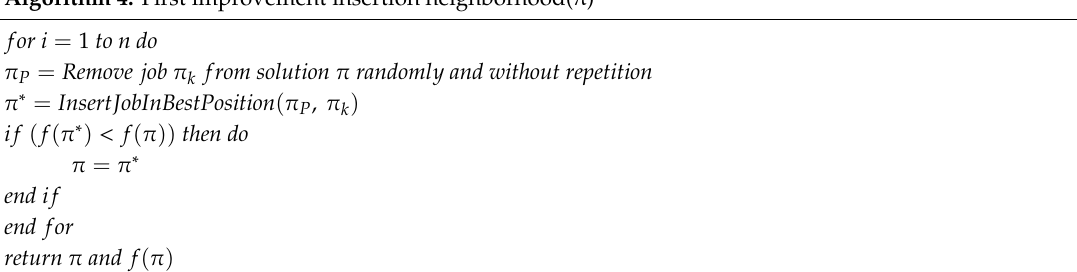
Algorithm 4: First improvement insertion neighborhood( π